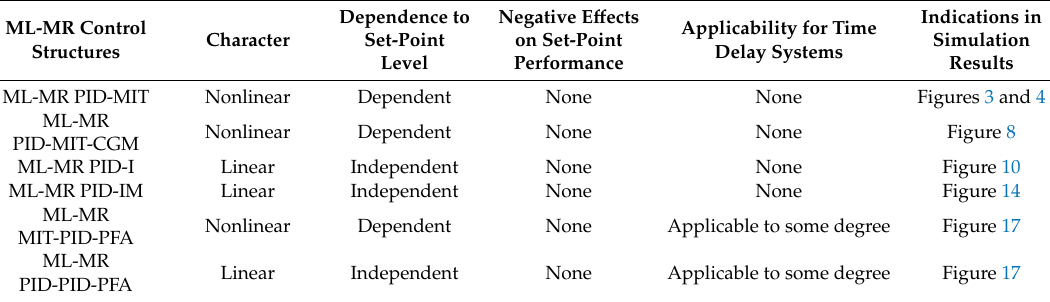
Table 2. Some properties of the presented ML-MR control